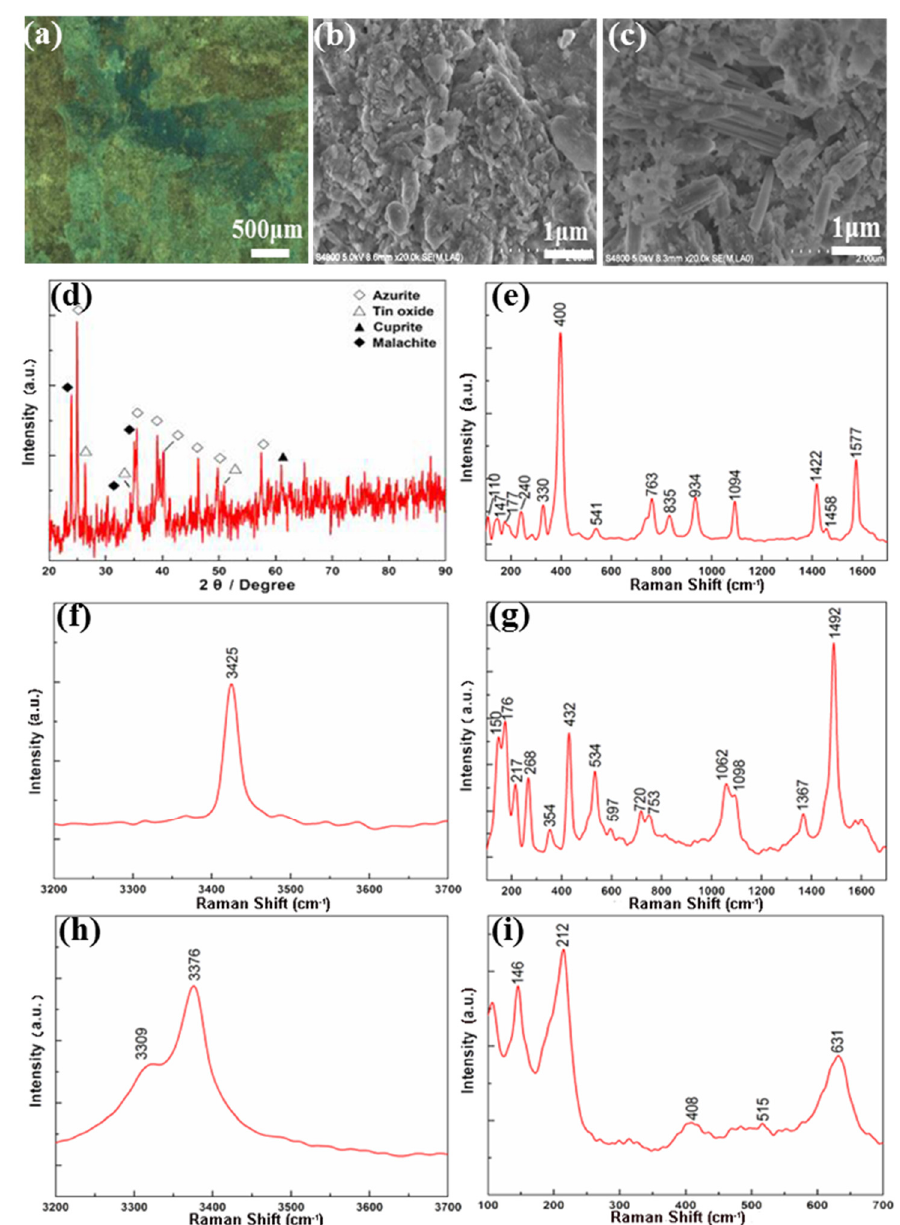
Figure 4. Characterizations of the corrosion products upon the bronze basin (Fu) (Spring and Autumn Period, collection No.: ABF-5155): ( a ) Optical image; ( b ) SEM morphology of the blue corrosion product; ( c ) SEM morphology of the green corrosion product; ( d ) XRD pattern; ( e ) and ( f ) Raman spectra of the blue corrosion product (azurite) in ranges 100–1700 cm − 1 and 3200–3700 cm − 1 , respectively; ( g ) and ( h ) Raman spectra of the green corrosion product (malachite) in ranges 100–1700 cm − 1 and 3200–3700 cm − 1 , respectively; ( i ) Raman spectrum of the green corrosion product (cuprite and cassiterite) in a range 100–700 cm − 1 .